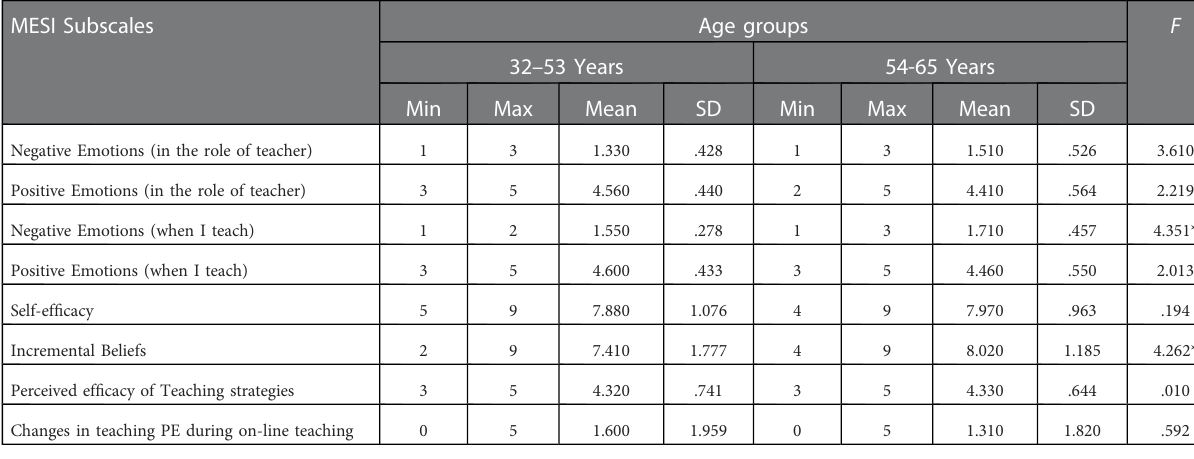
TABLE 3 Descriptive statistics and comparisons between age groups.